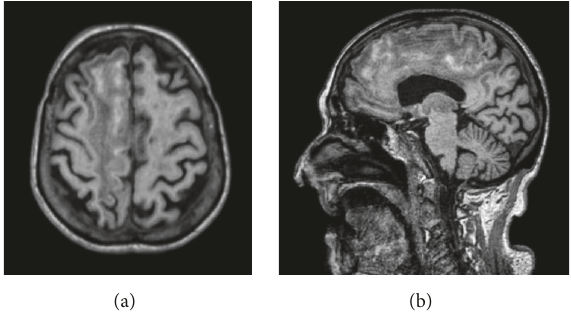
Figure 2: Axial (a) and sagittal (b) T1 weighted MR images. Linearspontaneoushyperintensityofthecortexinthefrontoparietal convexity, compatible with laminar necrosis.